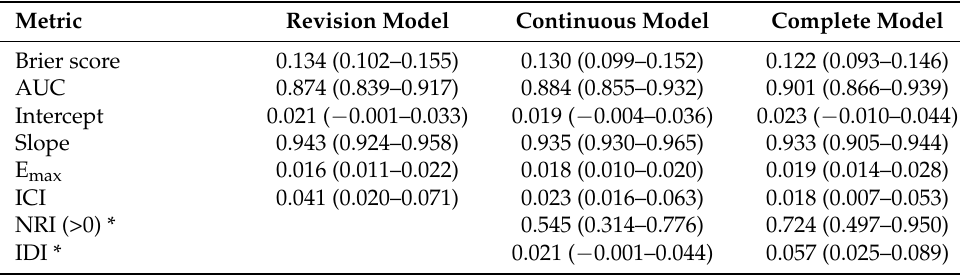
Table 3. Performance metrics of the developed